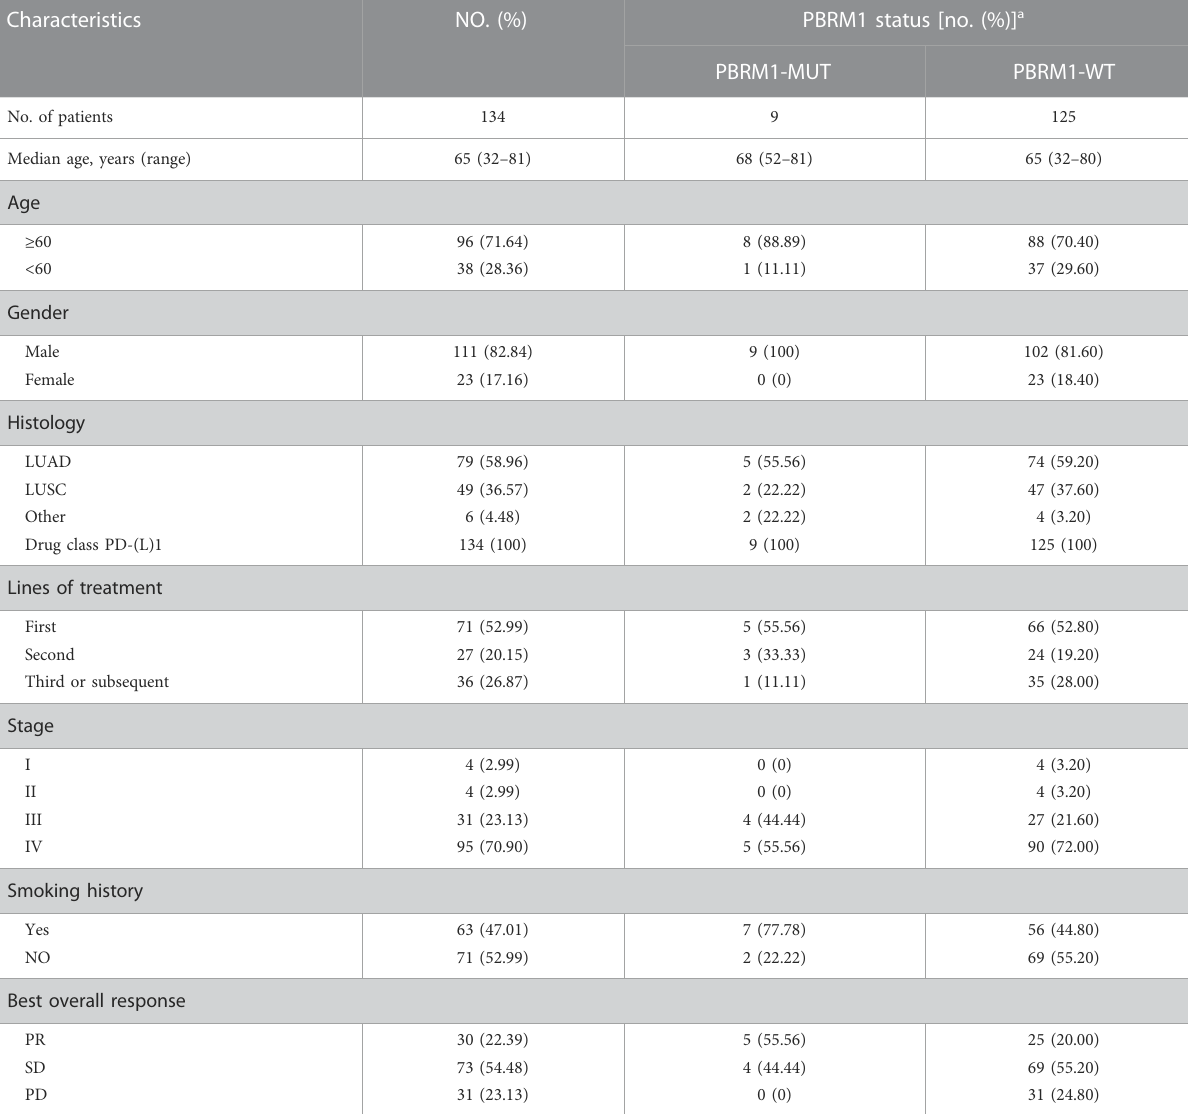
TABLE 2 Patient characteristics in the NSCLC cohort strati fi ed by PBRM1 status.